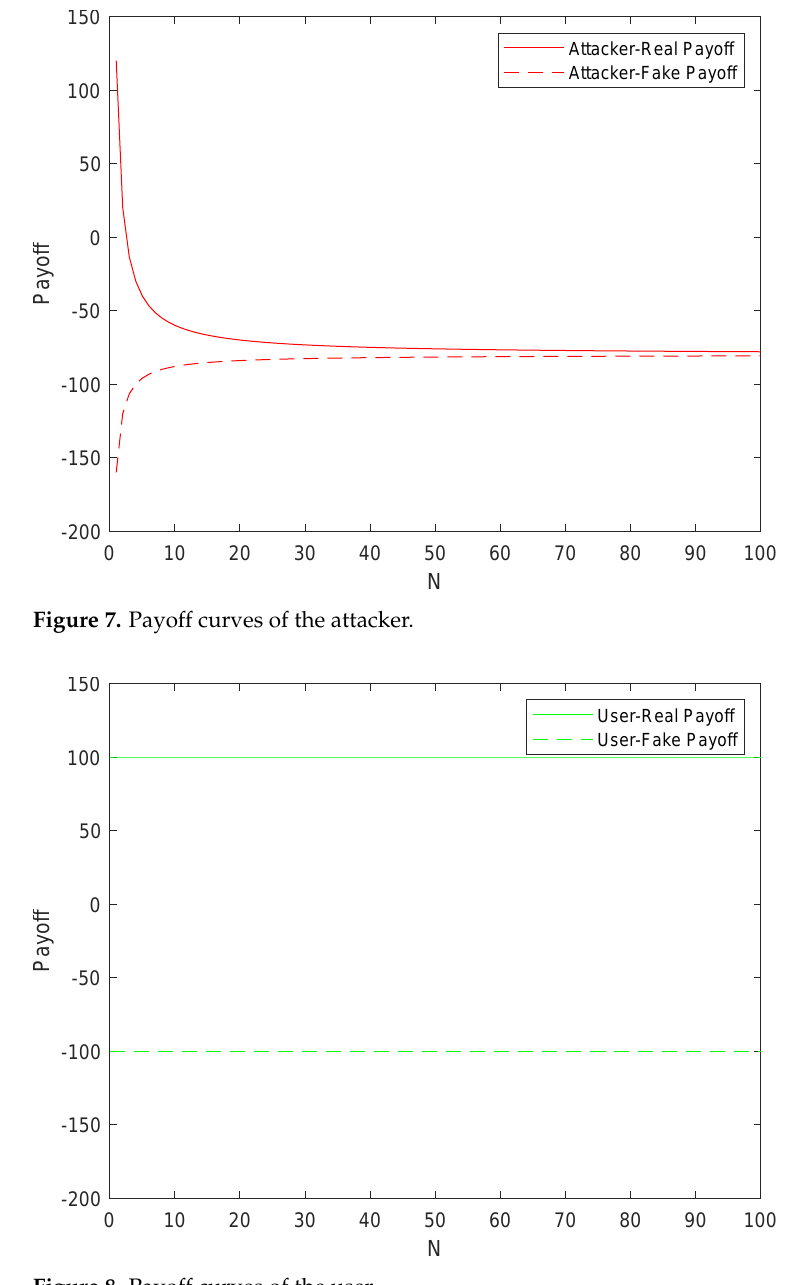
Figure 8. Payoff curves of the